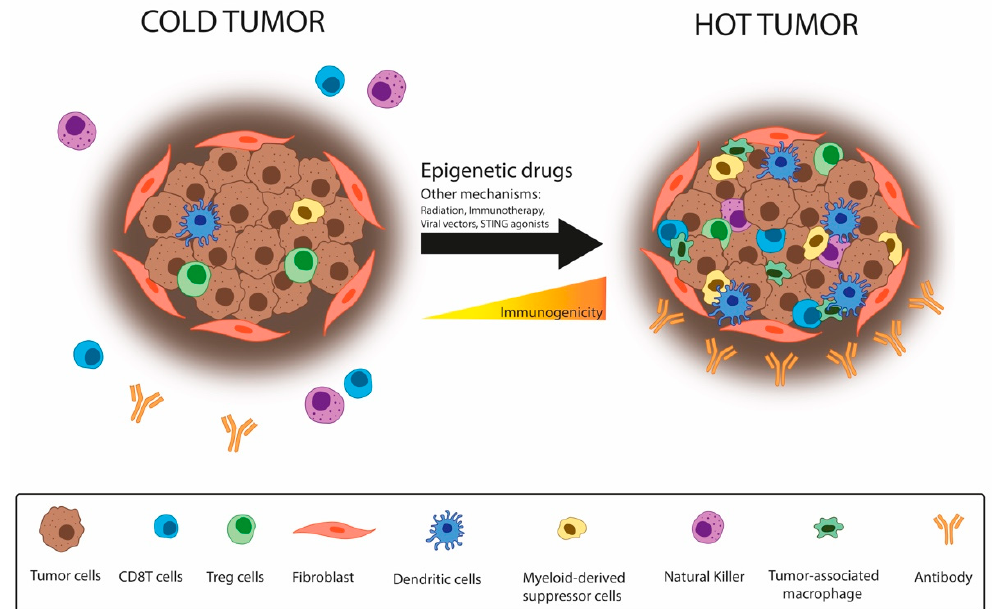
Figure 4. Epigenetic drugs contribute to turning cold tumors into hot. Cancer cells modulate their microenvironment to promote immune escape, increasing the presence of immunosuppressive cells on the tumor site and becoming a “cold tumor”, which displays a worse response against immunotherapy. Epigenetic drugs may switch this state, enhancing the immune response through the recruitment of CTLs, becoming a “hot tumor”. Hot tumors respond better to immunother- apy.